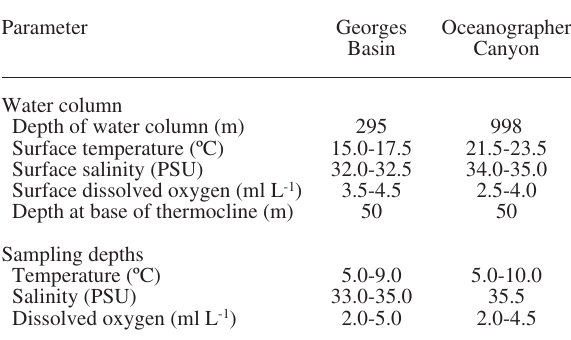
Table 2. – environmental conditions during